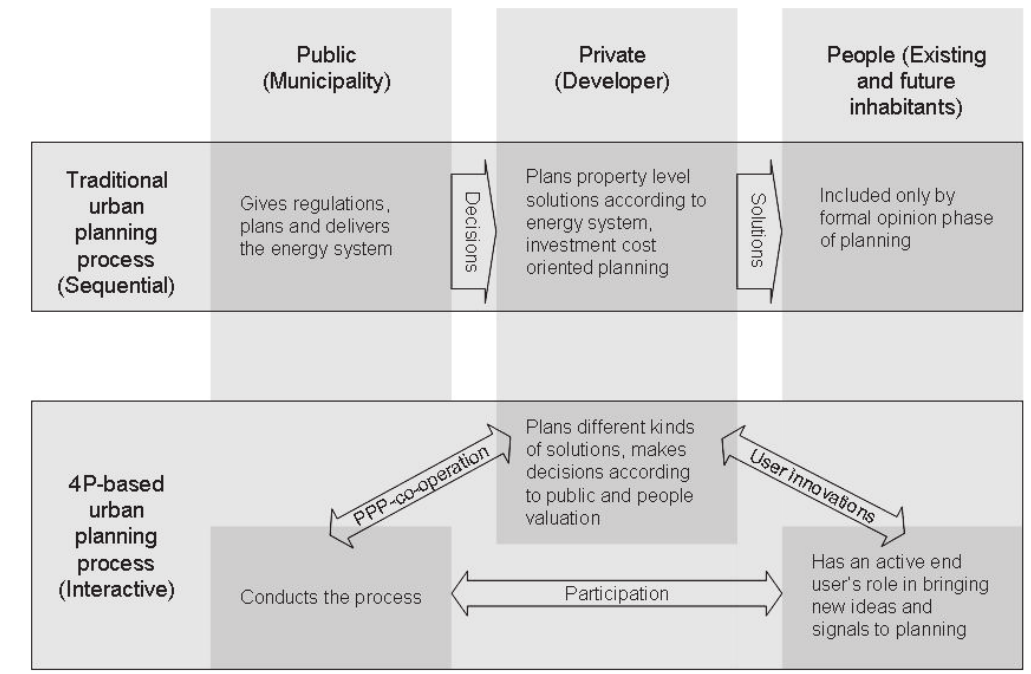
Figure 1. traditional and 4P urban planning process, where PPP is viewed as Public-Private relationship of